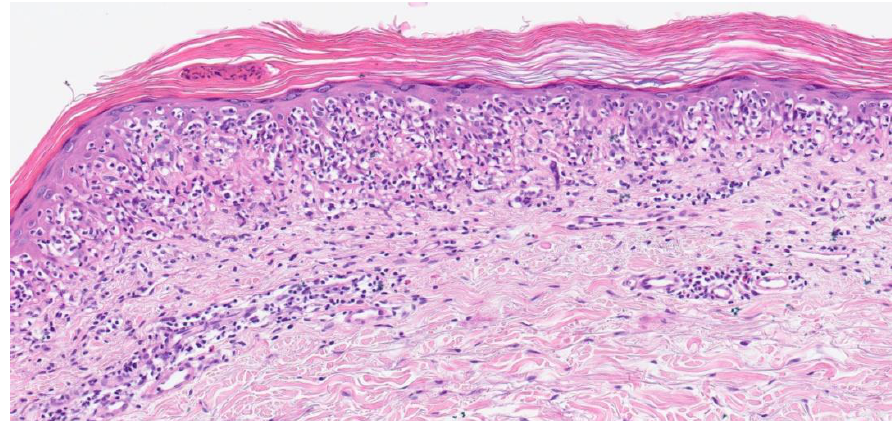
Figure 2. Hematoxylin-eosin stain revealed hyperparakeratosis and prominent epidermotropism of atypical lymphocytes also forming Pautrier’s microabscesses ( ×200).